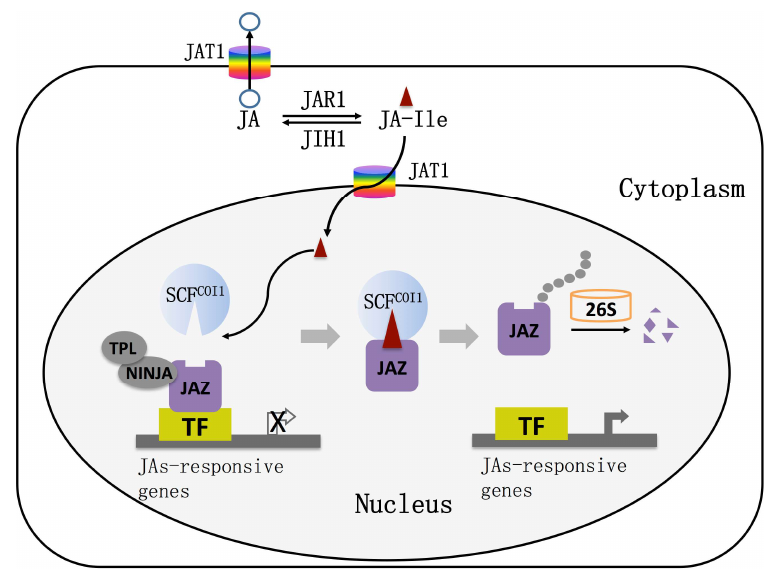
Figure 2. The working model of jasmonic acid transport and signaling pathway. JAT1: jasmonic acid transfer protein1; SCF: Skp1, Cullin and F-box proteins; COI1: coronatine insensitive1; JAZ: jasmonate ZIM-domain protein; TF: transcription factor; TPL: TOPLESS protein; NINJA: NOVEL INTERACTOR OF JAZ; 26S: 26S proteasome.